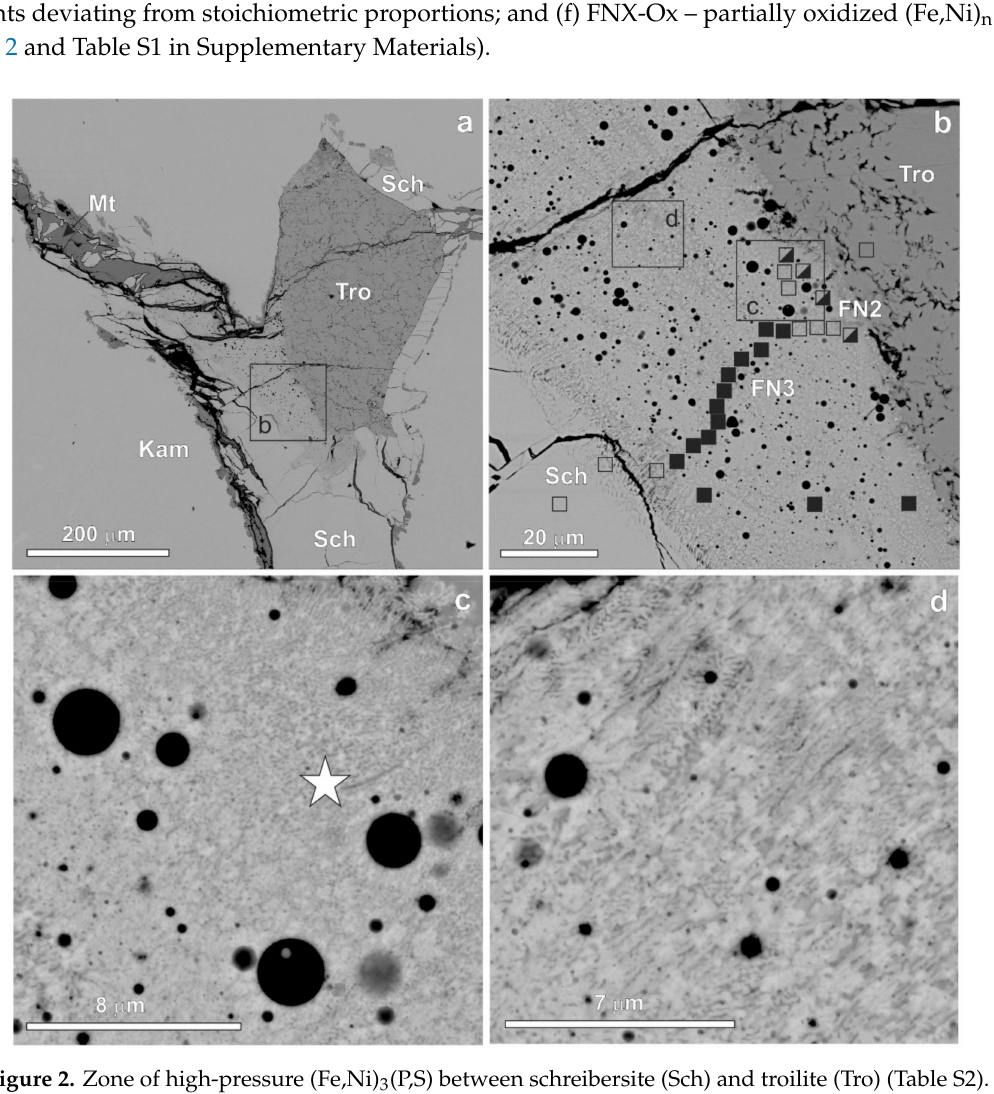
Figure 2. Zone of high-pressure (Fe,Ni) 3 (P,S) between schreibersite (Sch) and troilite (Tro) (Table S2). Squares show the positions of the EDS analyses: filled—FN3; half-filled—FN2, empty—others. The star shows the position of the EBSD pattern. Kam—kamacite;